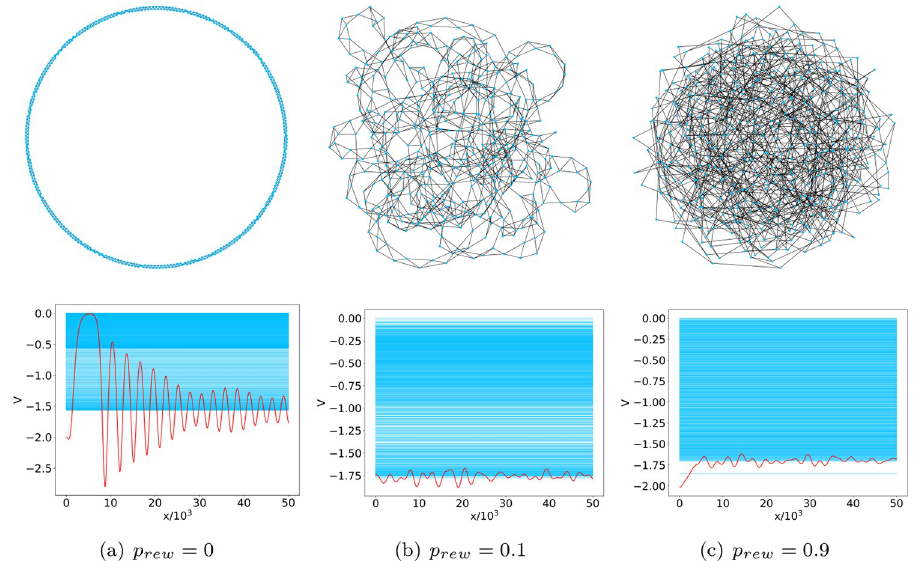
Fig 2. WS models with N = 500 nodes and the related reconstructed potentials. The figure shows how topological variability (upper panel), induced in a WS model with c = 4 by changing the rewiring probability, is captured by the reconstructed potentials (lower panel). Potentials (red) are superimposed to the network spectrum (pale blue). Notice that the potentials are even by construction.